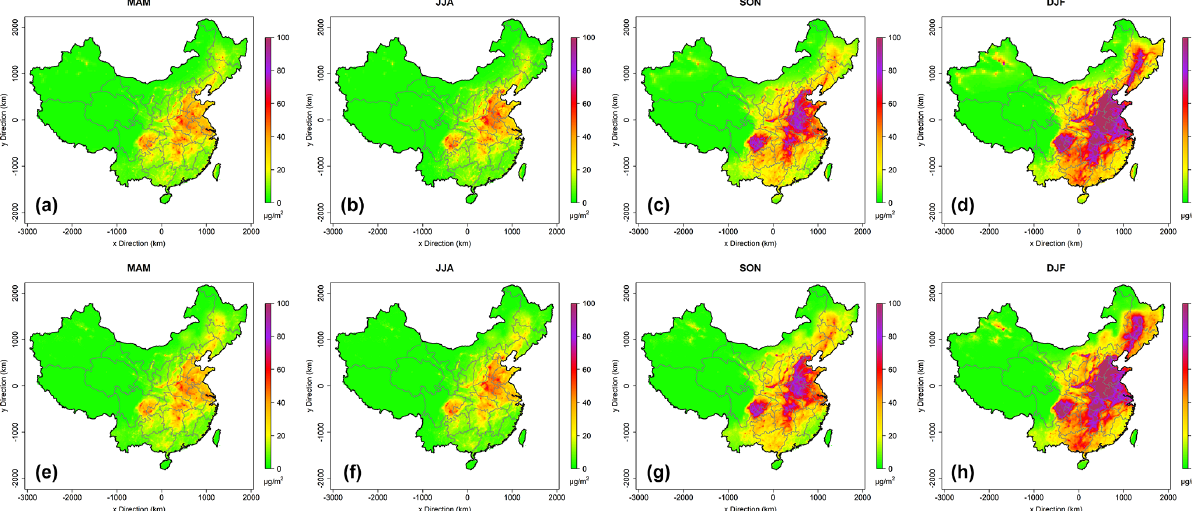
Figure 5. The seasonal average PM 2 . 5 concentrations of the raw CTM simulations ( a–d , first row) and the reproduced simulations using the data fusion model ( e–h , second row).